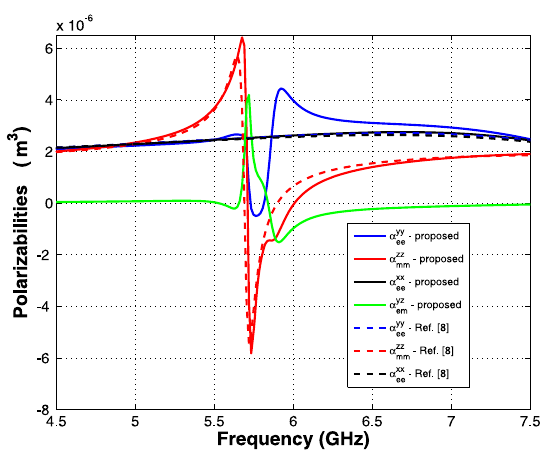
Figure 12: Detail of Fig. 11, including comparison of the results with those of [10].